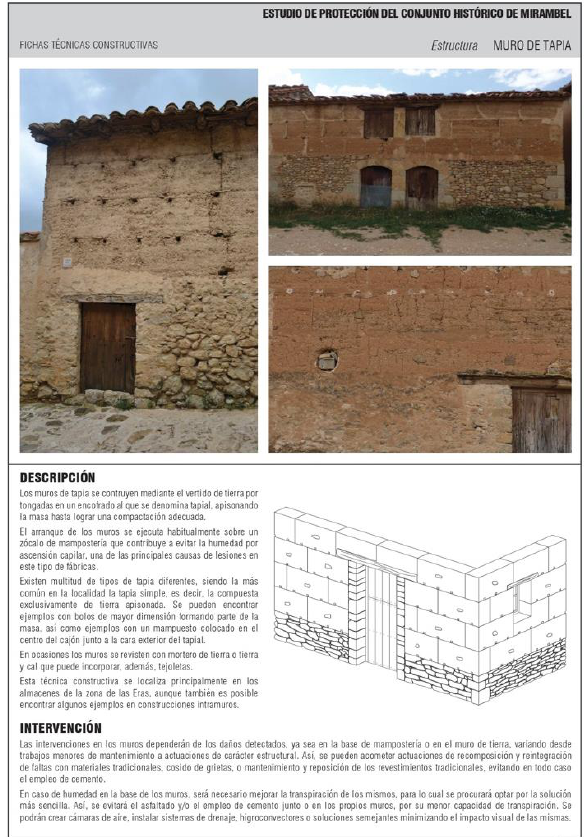
Figure 3. Extract of the typology inventory.